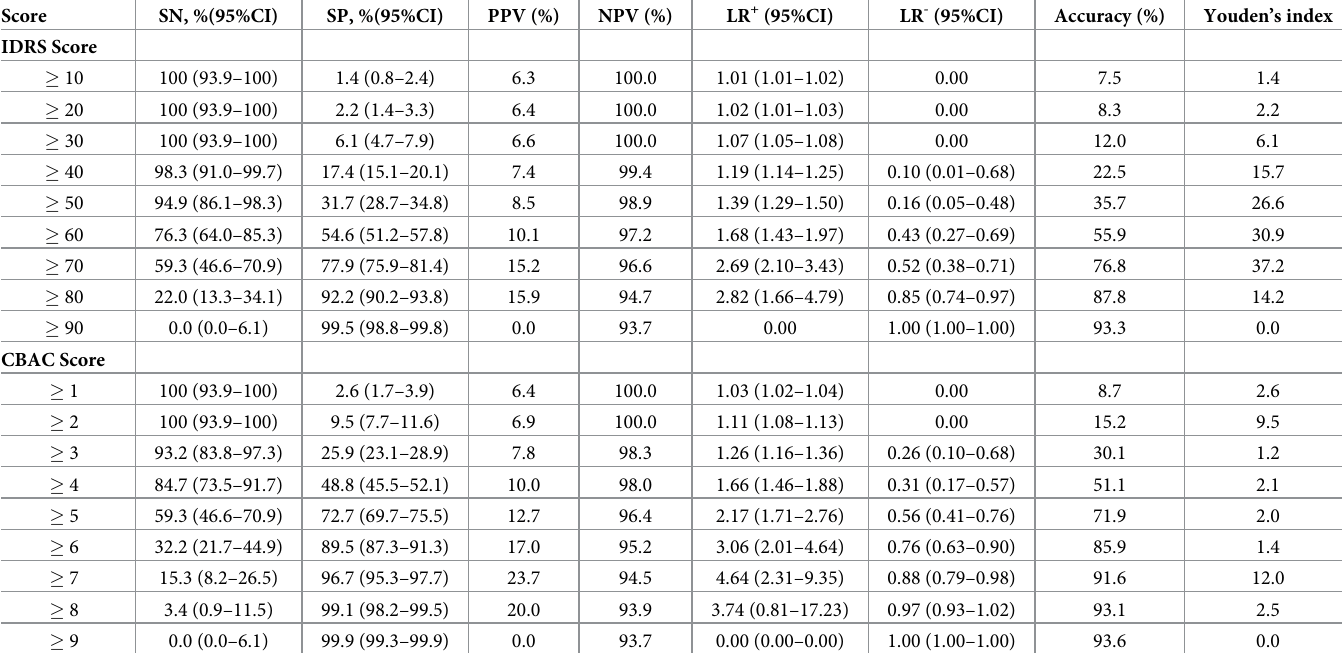
Table 4. Sensitivity, specificity, PPV, NPV, LR + , LR - , accuracy, and Youden’s index of IDRS and CBAC scores to diagnose Met